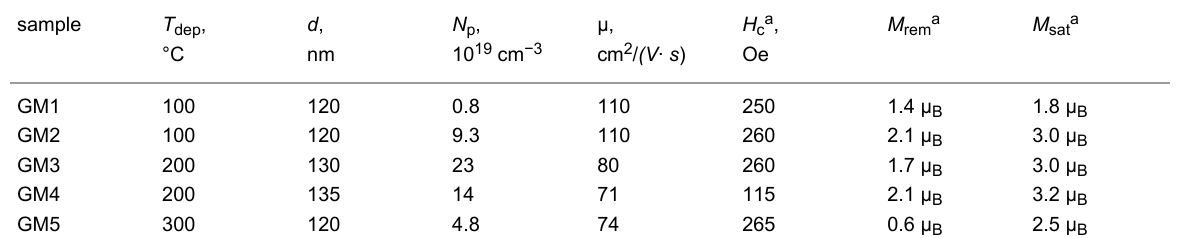
Table 1: Sample parameters: deposition temperature T dep ; film thickness d ; carrier concentration N p ; carrier mobility μ ; coercive force H c ; remanent magnetization M